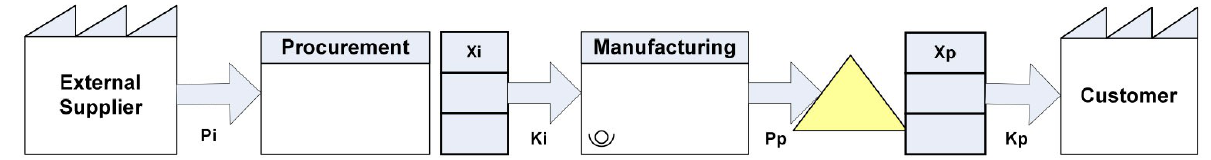
Figure 2. Variables and parameters in value stream